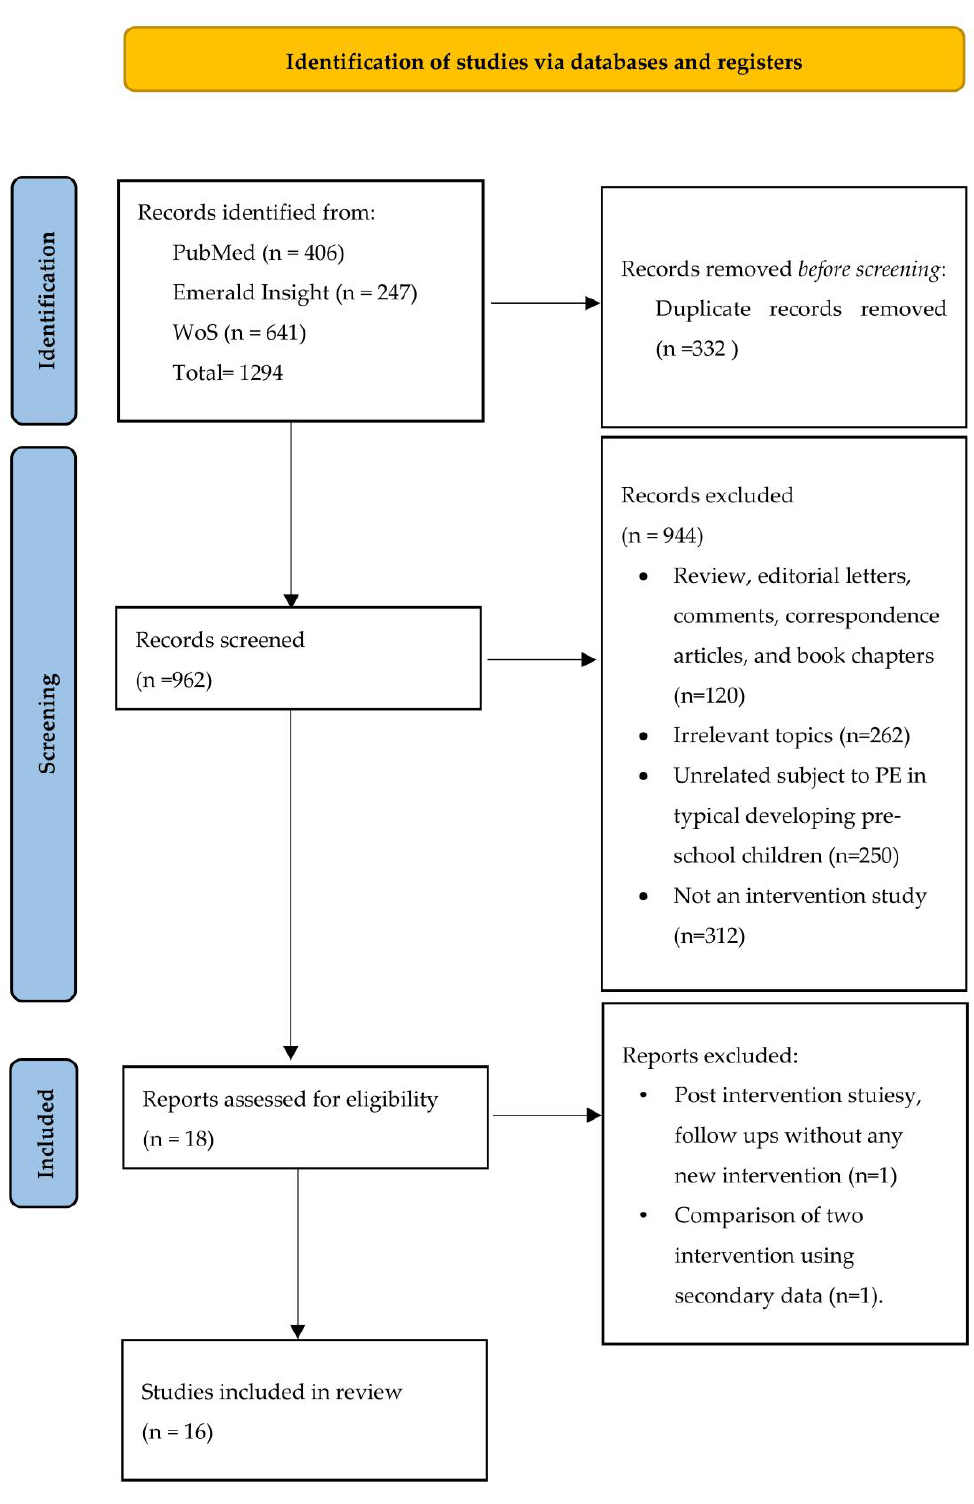
Figure 1. Literature screening process.